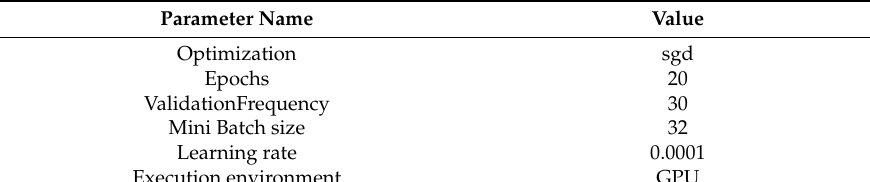
Figure 11. CNN training ratio distribution diagram for detection of strawberry diseases. Table 2. Model training parameters.